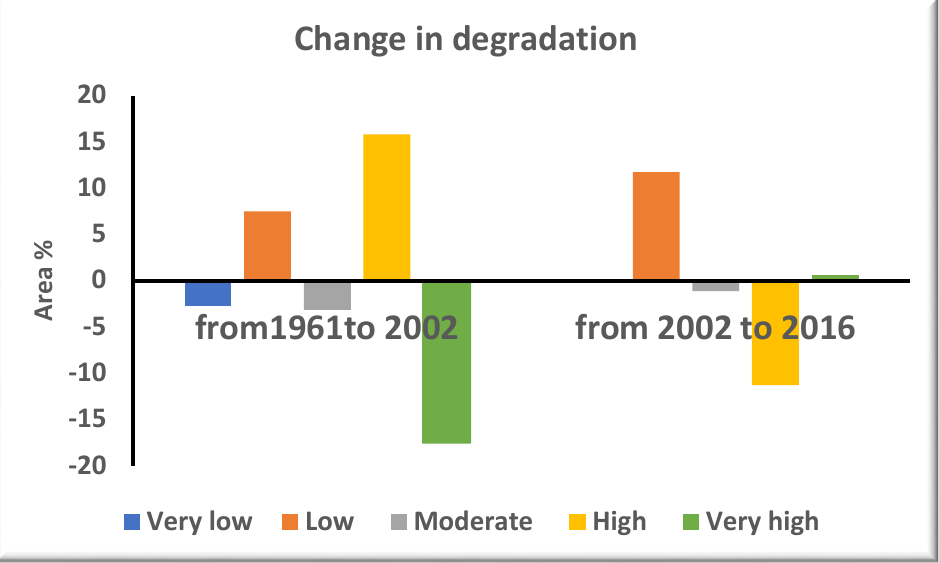
Figure 16. Overall qualitative soil degradation types in 1961, 2002, and 2016.